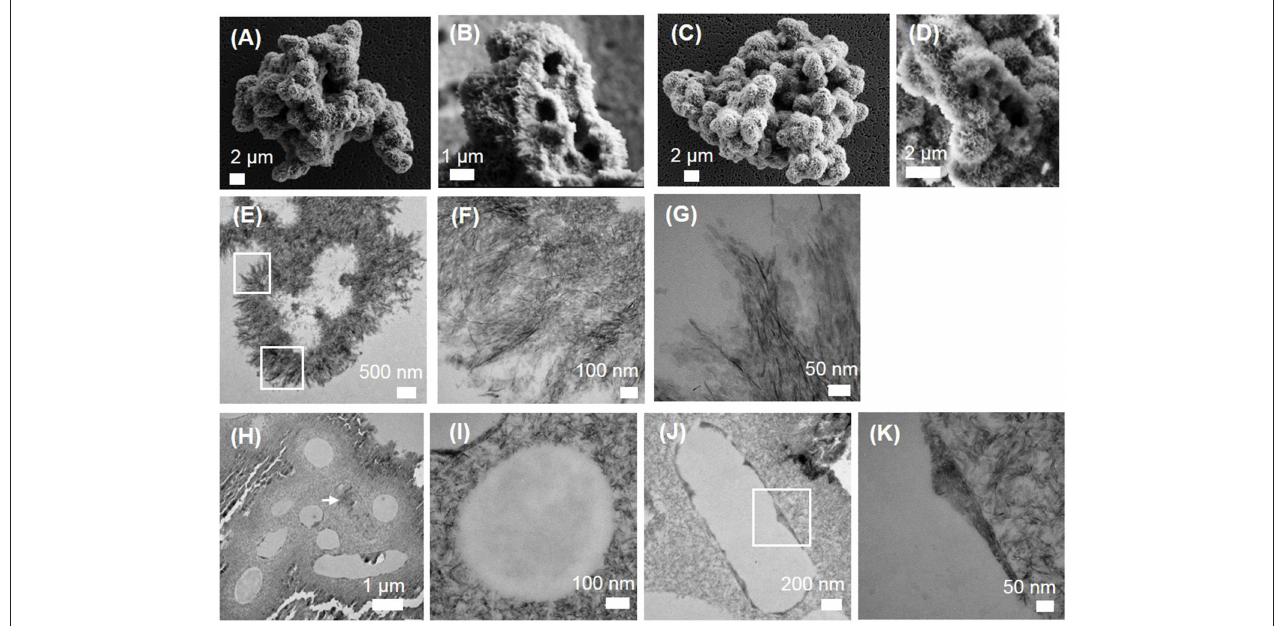
FIGURE 6 | SEM and TEM images of calcification by PHO A in the absence or the presence of WT E. coli . (A,B) SEM images of calcification by PHO A in the absence of WT E. coli . (C,D) SEM images of calcification by PHO A in the presence of WT E. coli . Clusters of spherical or ovoid void structures, measuring ∼ 2 µ m in diameter are formed in both cases. (E–G) TEM images of calcification by PHO A in the absence of WT E. coli . (F) and (G) are close-ups of the areas depicted by rectangle on (E) . (H–K) TEM images of calcification by PHO A in the presence of WT E. coli . (H) Most cells are empty, with a few exceptions (white arrow). The cell on (J) is surrounded by an electron-dense discontinuous layer of Ca-phosphate. (K) is a close-up of the area depicted by rectangle on (J) . The Ca-phosphates forming the discontinuous electron-dense layer are needle-like, and oriented tangentially to the border of the